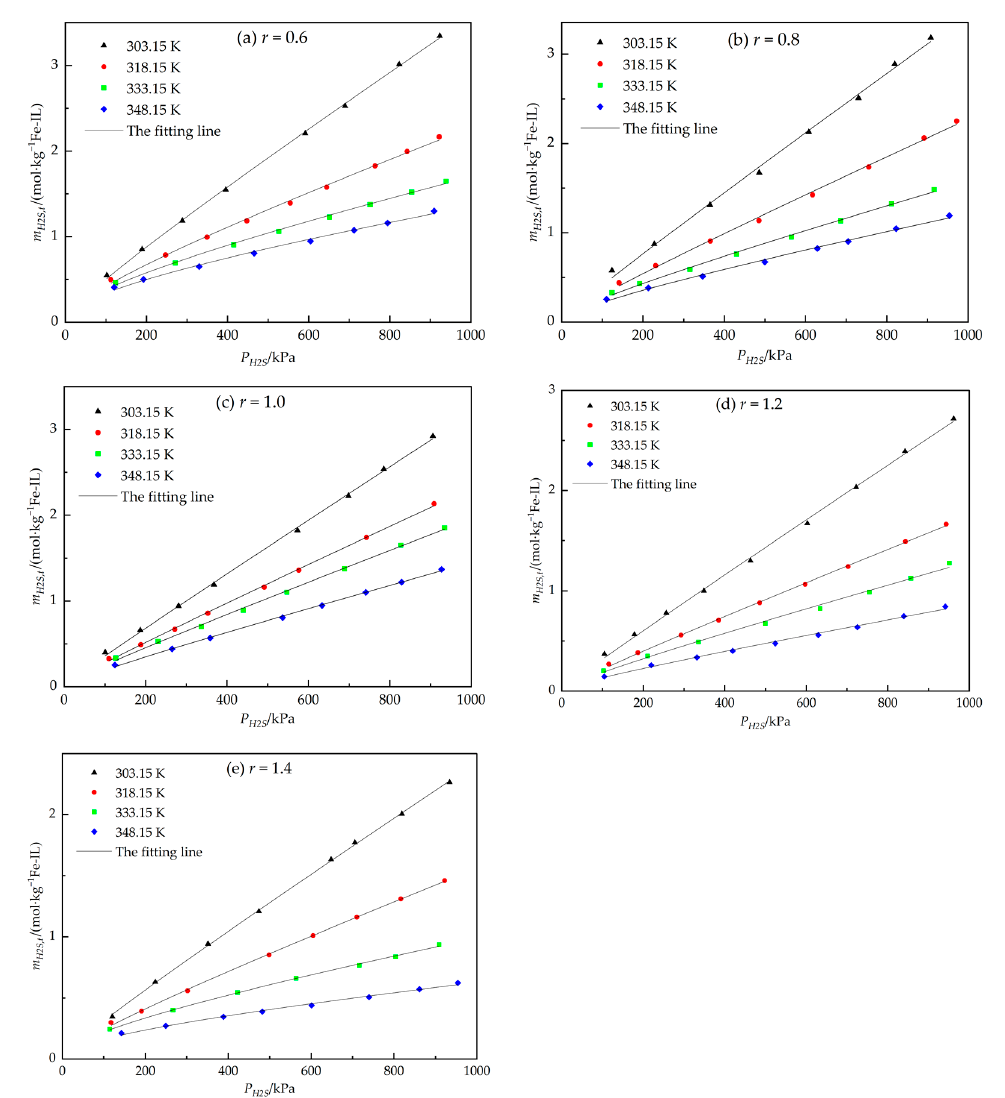
Figure 3. Experimental results for the solubility of H 2 S in r FeCl 3 /[bmim]Cl: ( a ) r =0.6; ( b ) r =0.8; ( c ) r =1.0; ( d ) r =1.2; ( e ) r =1.4.